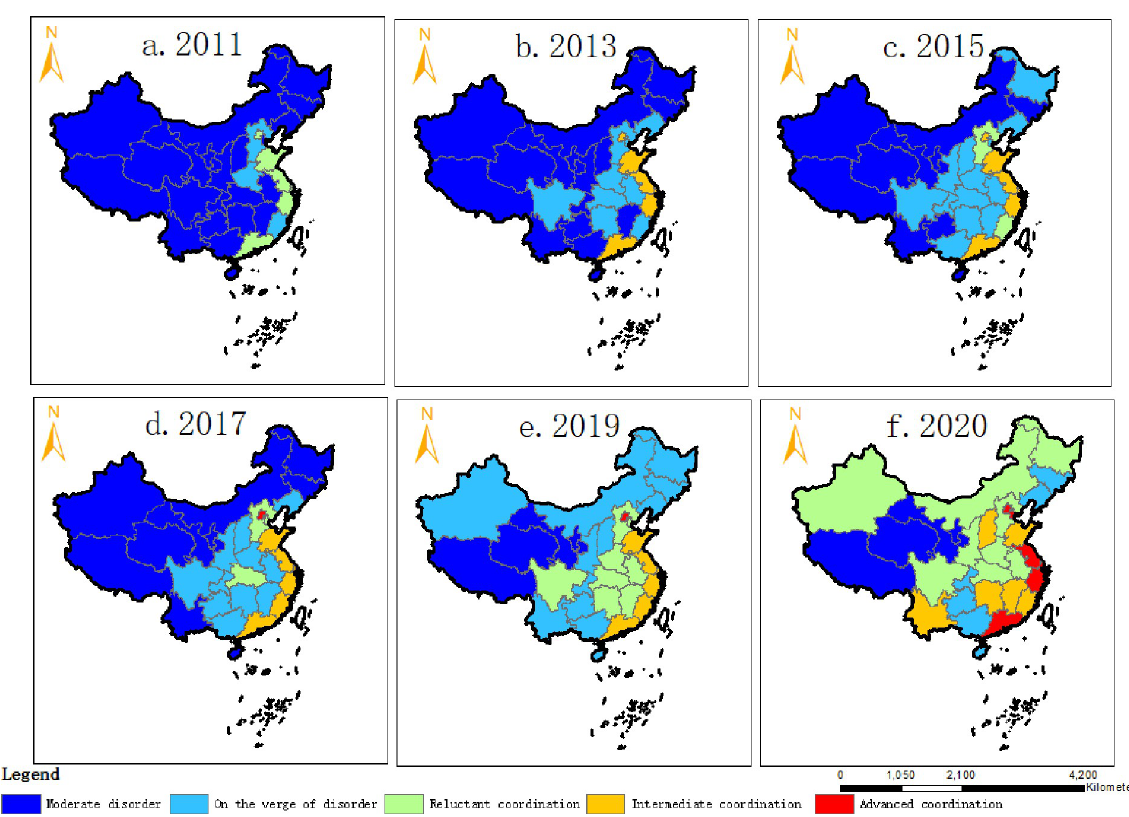
Fig 4. Spatial distribution characteristics of the coupling and coordination degree of digital economy and rural revitalization in China.